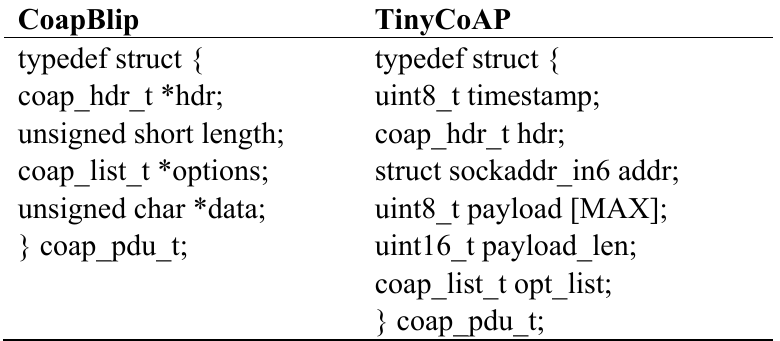
Table 1. CoAP PDU structures. CoapBlip stores the PDU in the UDP buffer and uses a pointer to provide access. TinyCoAP saves it in the memory allocated with